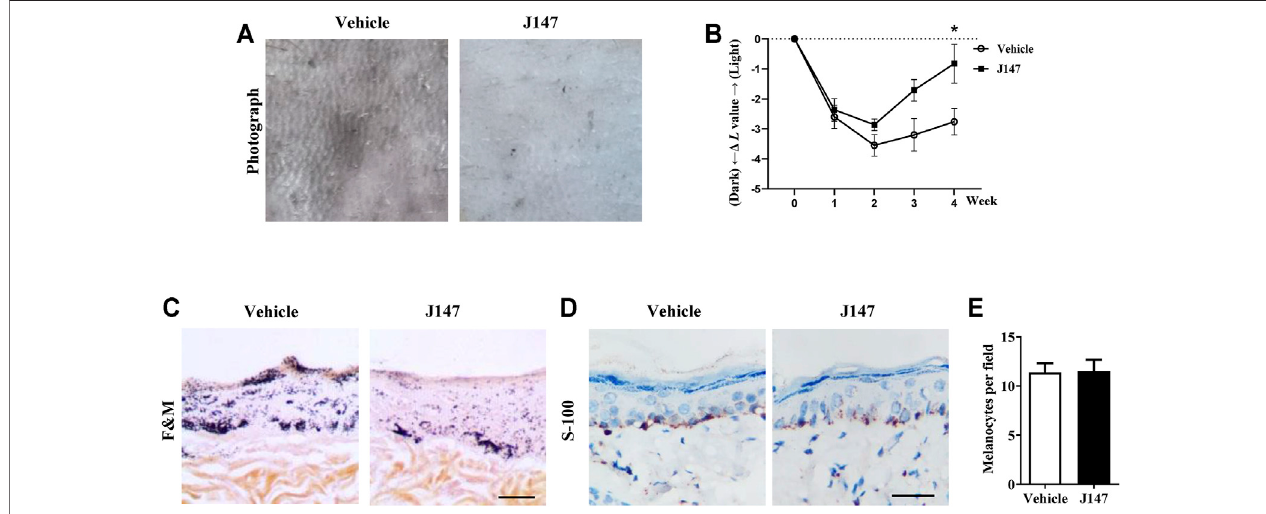
FIGURE8| EffectofJ147onpigmentationinguinea-pigskin. (A) Representativephotographsofdorsalskinofguineapigs. (B) Thedegreeofdepigmentationwas determined by a chromameter (CR-300; Minolta, Osaka, Japan) once a week for 4 weeks. The Δ L value was calculated using the L value (brightness index) measured with the chromameter follows: Δ L (cid:2) L (at each week measured) — L (at day 0). Negative Δ L values indicate an UV-induced darkening of the skin. An increase in the Δ L value indicates a decrease in hyperpigmentation induced by UV. (C) Masson – Fontana ammoniacal silver staining of skin biopsies. (D) Immunohistochemical staining of skin biopsies for the detection of S-100 as a melanocyte marker protein. (E) Number of melanocytes per microscopic fi eld in skin sections. Bar (cid:2) 50 μ m * p < 0.05 vs. vehicle-treated